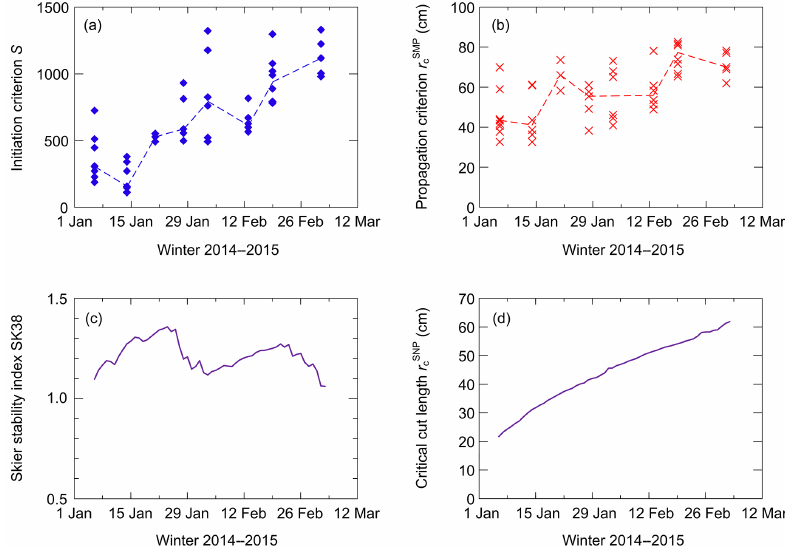
Figure 5. Instability criteria: (a) SMP-derived failure initiation criterion S and (b) SMP-derived crack propagation criterion r SMP c ; dashed lines connect median values per day ( N = 48). Output of the numerical snow cover model SNOWPACK: (c) skier stability index SK38 and (d) modelled critical cut length r SNP c